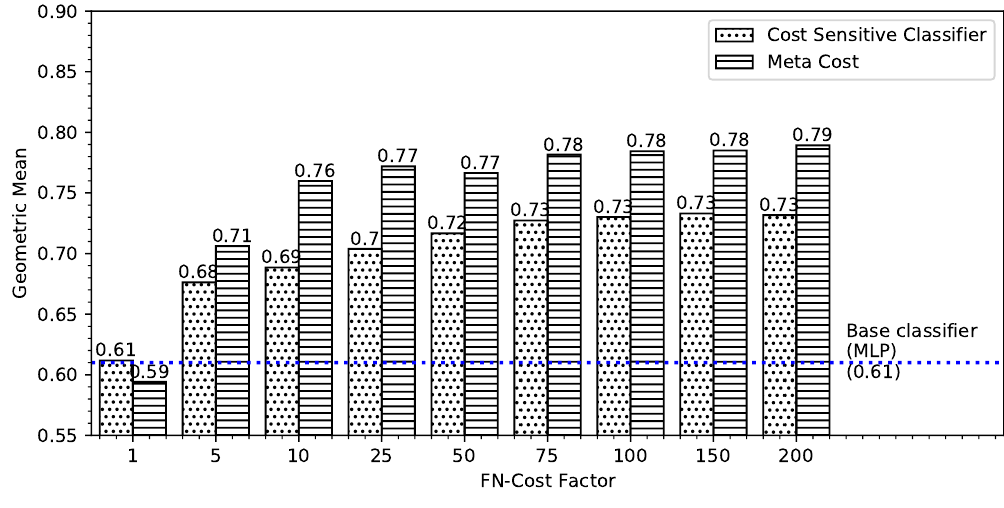
Figure 3. The effect of Adjusting FN-Cost Factor on Geometric